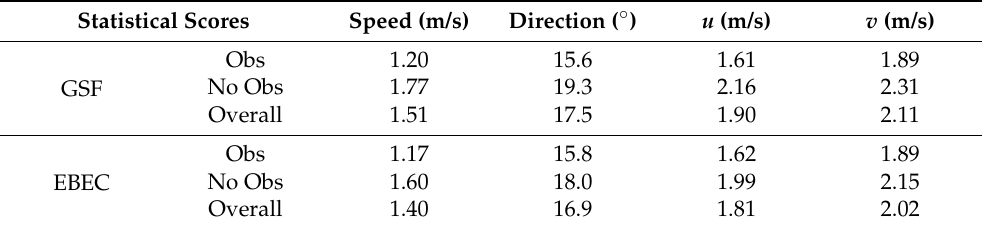
Table 5. SD scores of the blended winds with regards to. buoy measurements.